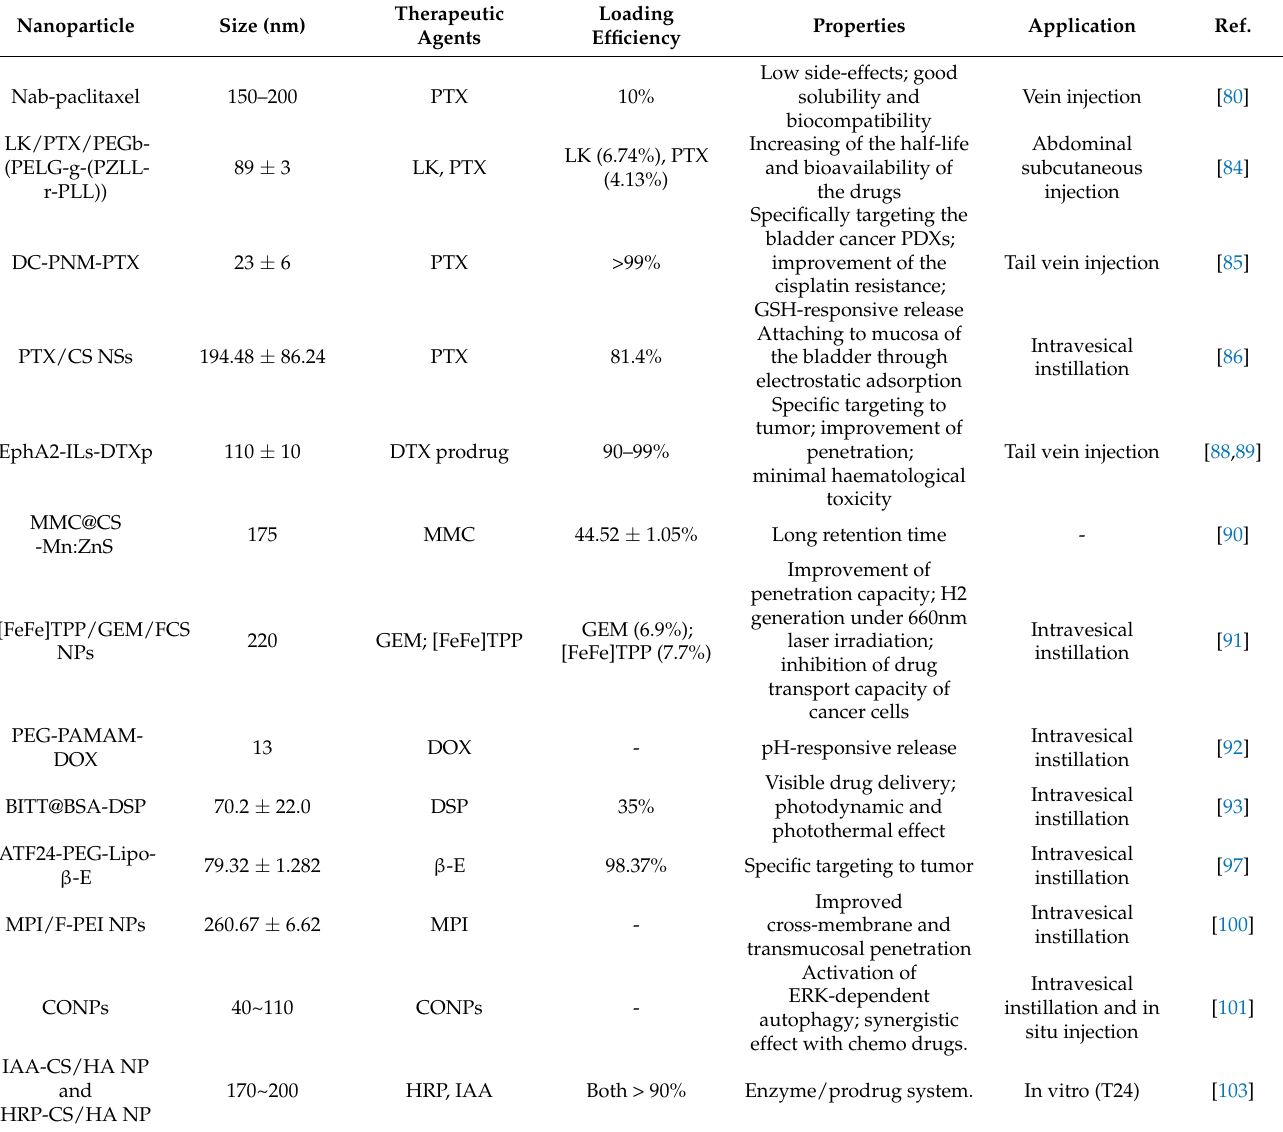
Table 4. Nano-formulations for